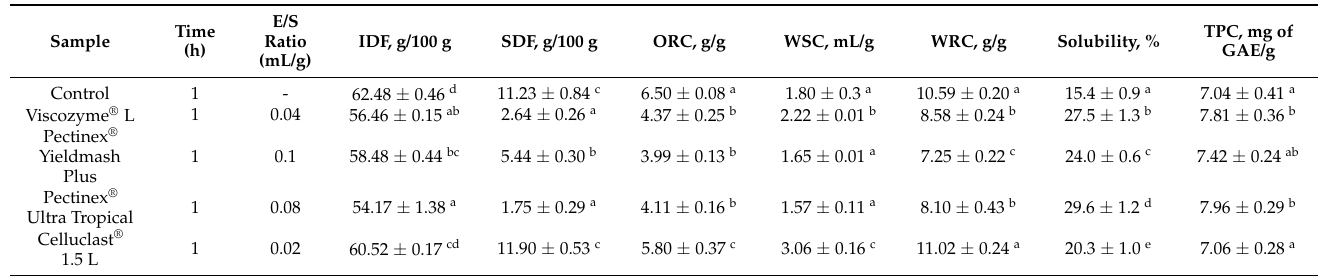
Table 4. Dietary fiber, TPC content and technological properties of enzymatically treated cranberry